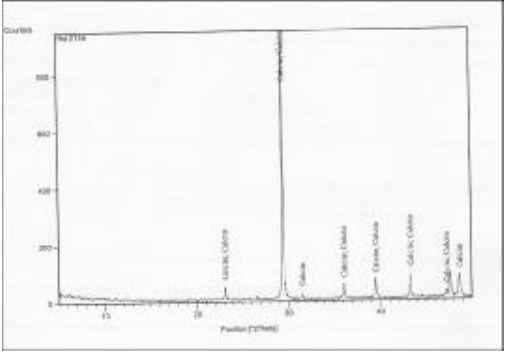
Figure 3: The XRD analysis for the first sample